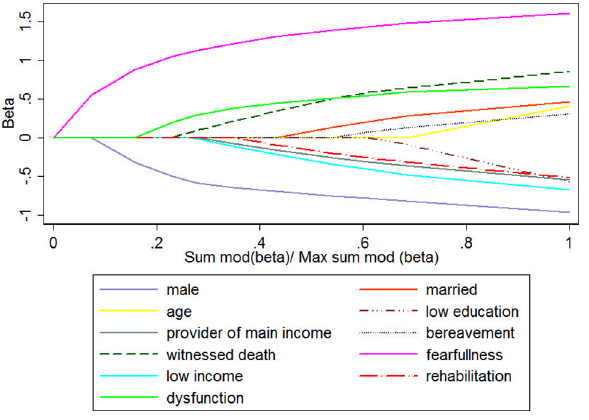
Figure 2. Graphical Depiction of Variable Selection from Least Angle